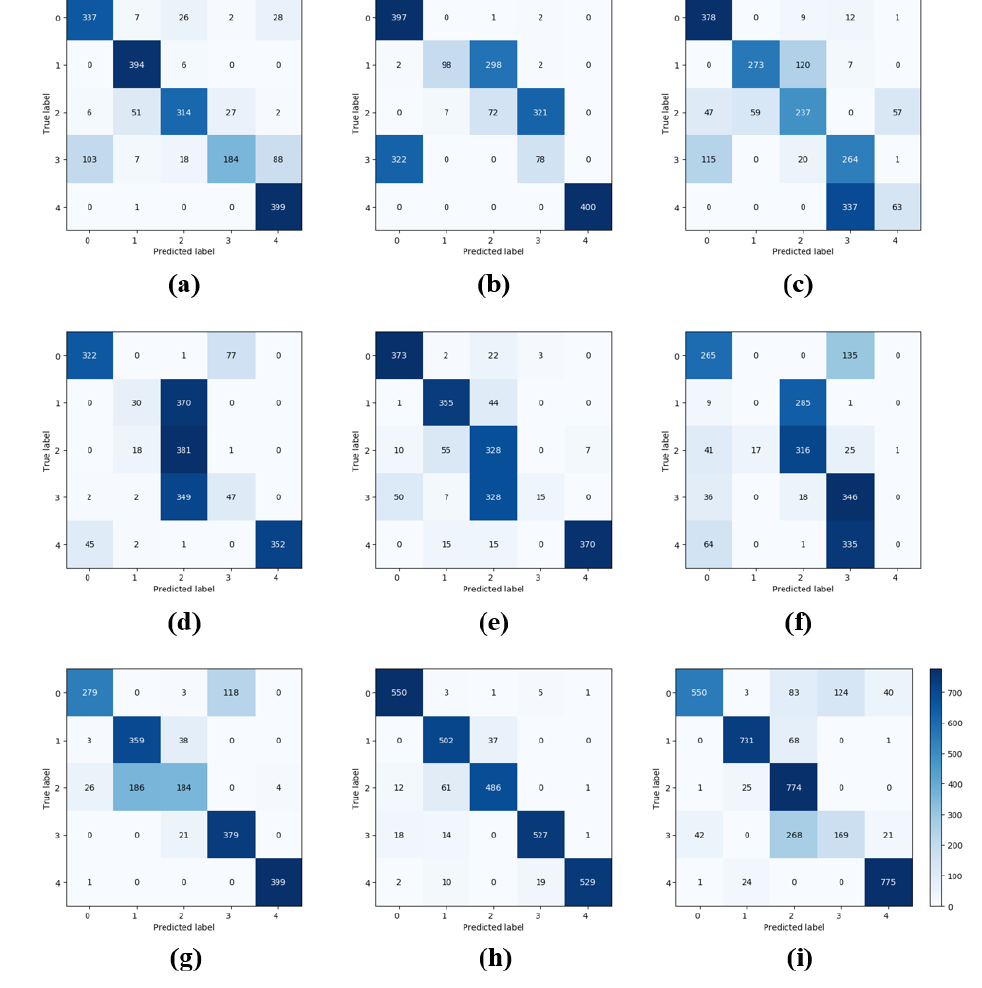
Figure 7. Confusion matrix obtained from the experiments of “city-wise holdout cross validation” with test cities for ( a ) Cape Town, ( b ) Casablanca, ( c ) Lagos, ( d ) Lusaka, ( e ) Nairobi, ( f ) Niamey, ( g ) Cairo, and ( h ) “Sample-wise cross validation” as well as ( i ) “Fixed